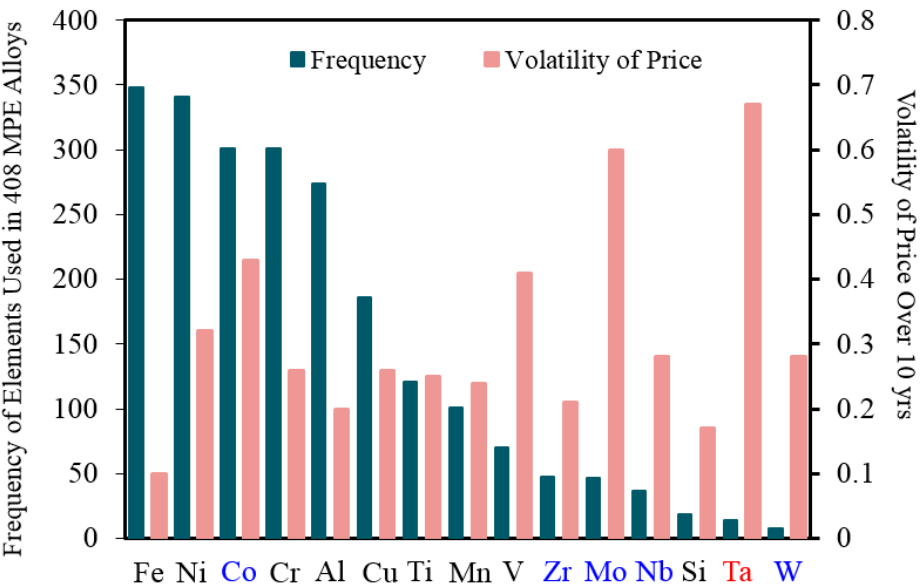
Figure 2. The most common elements used in MPE alloys [1] and their volatility of prices over a period of 10 years. Black elements have a low price (~$0.5/mole of average 50 years), blue elements have an intermediate price (~$5/mole of average 50 years), and the red element has a high price (~$100/mole of average 50 years) [11].